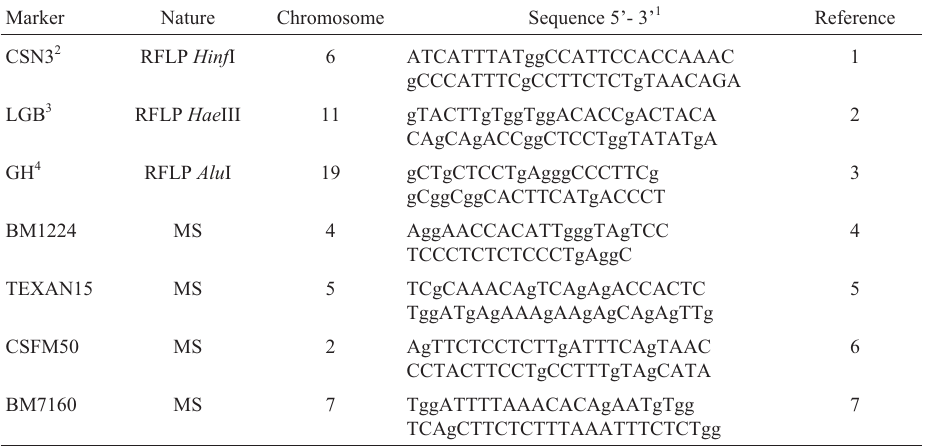
Table 1 - Description of molecular markers